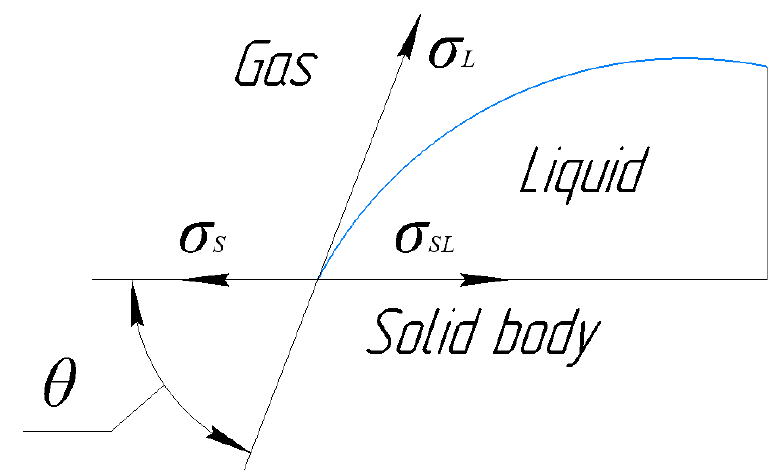
Figure 3. Surface tension forces and the contact angle applied to the composition droplet on a solid surface. σ S —surface tensions between the solid and gas phases, σ L —between the gas and liquid phases, σ SL —between the liquid and solid phases, θ —the contact angle. The surface tension may be evaluated by the shape and size of a drop hanging from a syringe needle, on the condition the drop is in the hydro-mechanical equilibrium